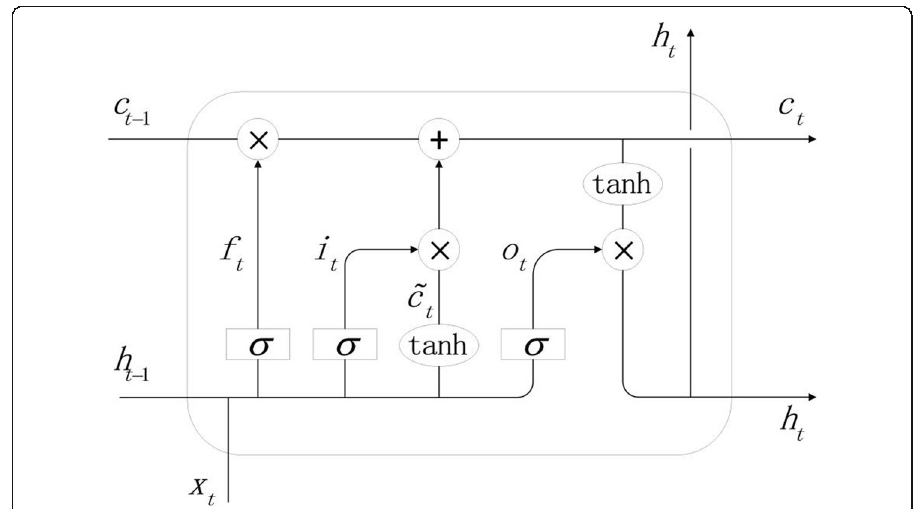
Fig. 4 Structure of an LSTM